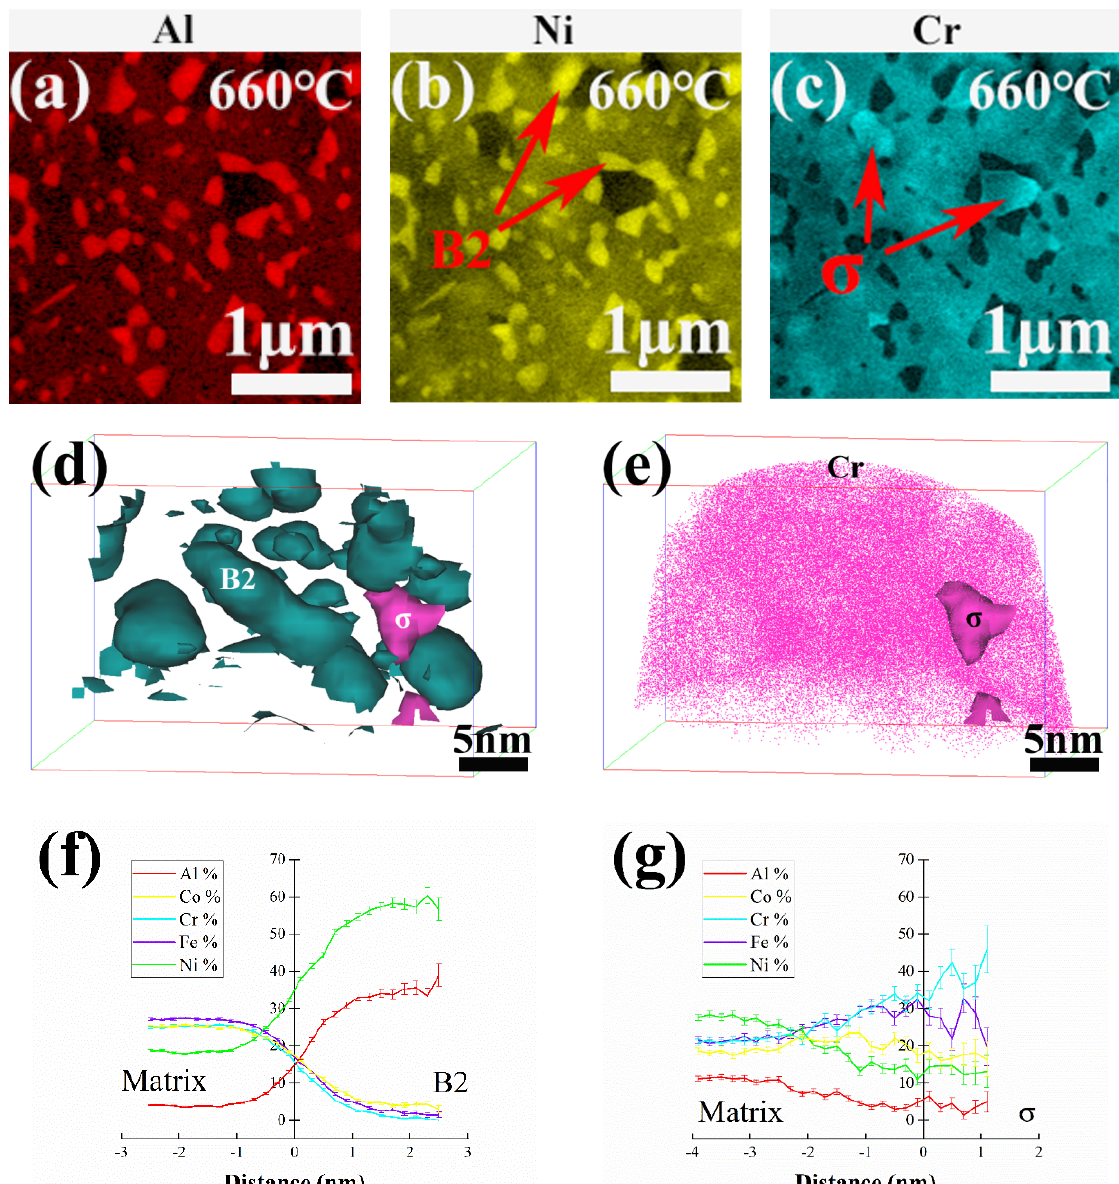
Figure 9. Elemental energy spectrum mappings of AR660 sample and 3DAP reconstruction images with corresponding concentration curves of Al, Co, Cr, Fe, Ni elements of B2 and σ phase in AR590 sample: ( a – c ) Al, Ni, Cr elemental energy spectrum mappings of AR660 sample; ( d , e ) 3DAP recon- struction images of B2 and σ in AR590 sample; ( f ) element concentration curves of B2 phase and matrix in AR590 sample at atomic percentage; ( g ) element concentration curves of σ phase and matrix in AR590 sample at atomic percentage.